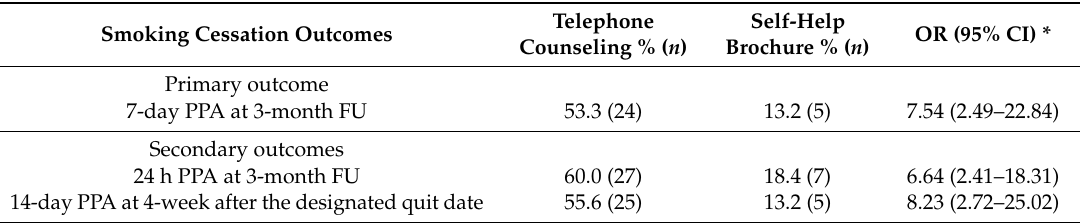
Table 2. Smoking cessation outcomes between intervention ( n = 45) and control condition ( n = 38).